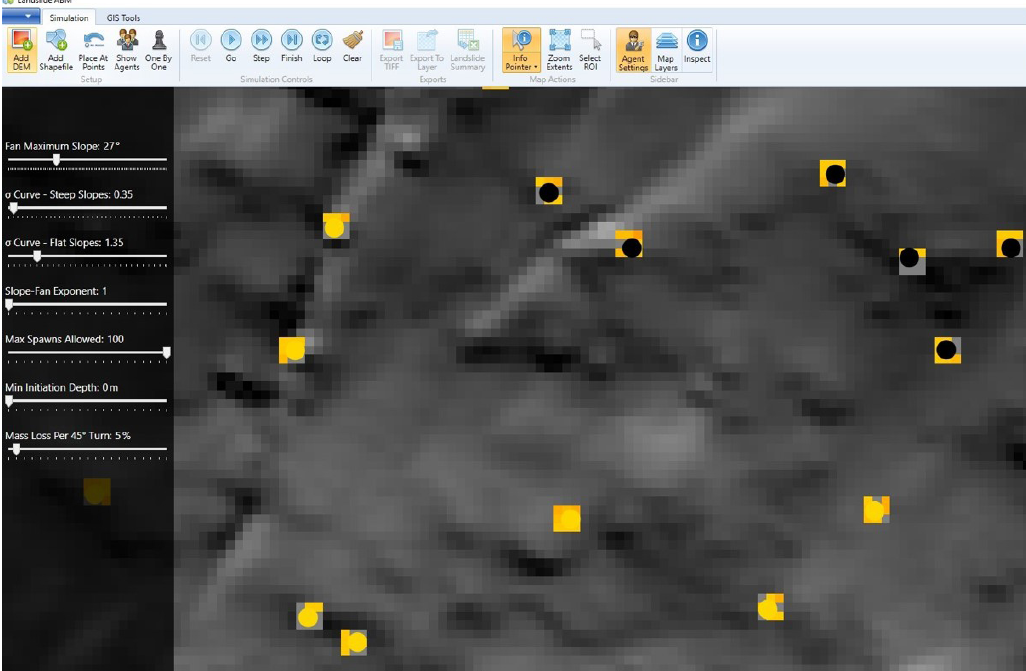
Figure 18. A close-up view of landslide initiation points and the DebrisFlow Predictor generated 15m × 15m initiation zones. Each zone contains nine agents. The sliders on the left control agent behavior as explained in the Methods